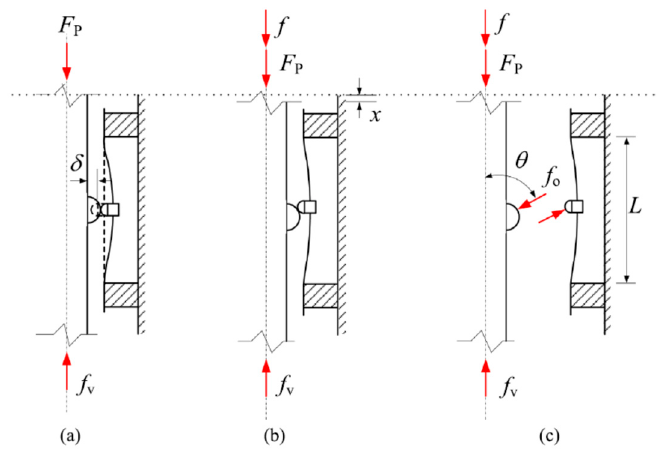
Figure 7. Schematic diagram of static analysis. ( a ) Static equilibrium position; ( b ) a compression x under an external force f load; ( c ) forces applied on the rod and the flexible beam.